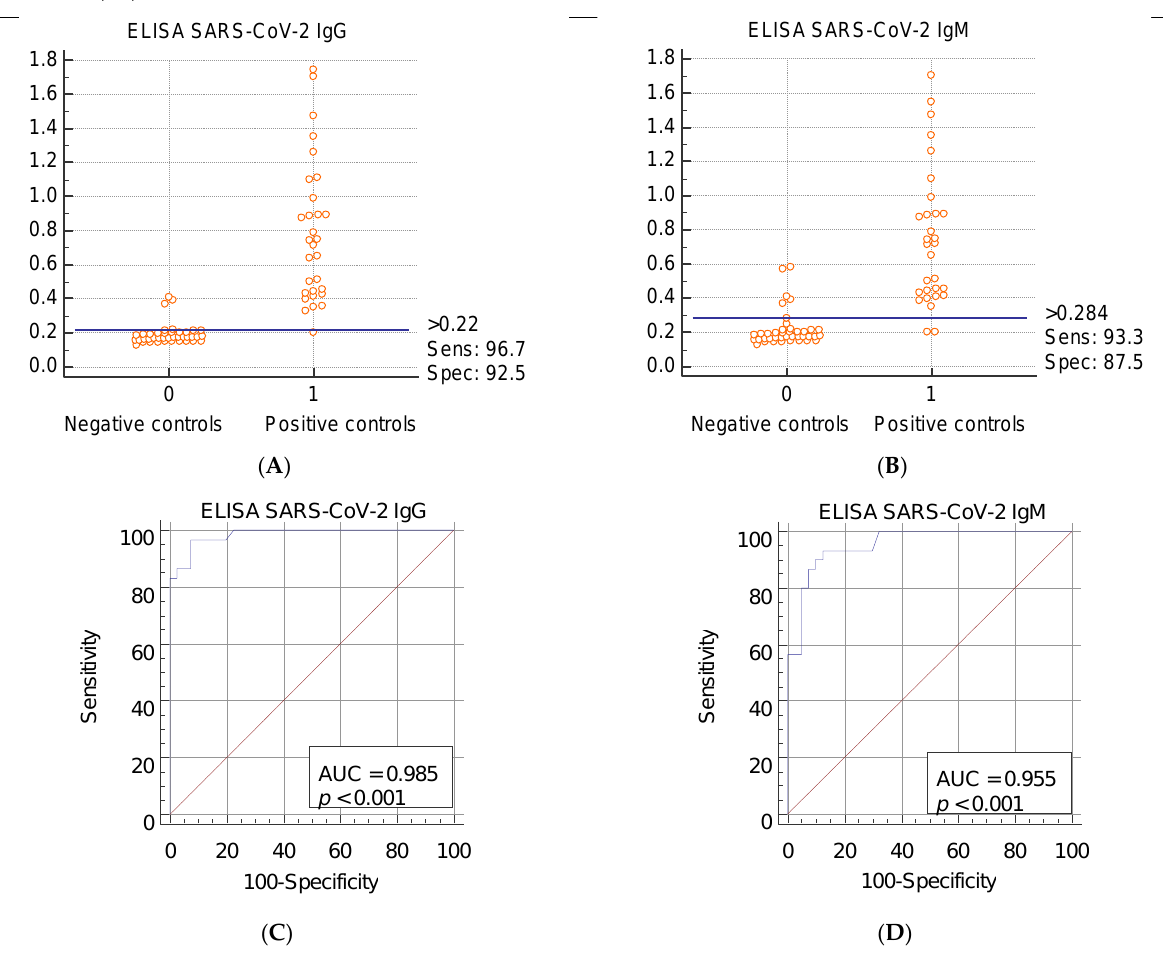
Figure 4. Distribution of the OD values obtained from 40 SARS-CoV-2 negative and 30 SARS-CoV-2 positive human sera samples using recombinant M protein-based SARS-CoV-2 IgG ( A ) and IgM ( B ) indirect ELISA. The ROC curve built for 40 SARS-CoV-2 negative and 30 SARS-CoV-2 positive human sera analyzed by SARS-CoV-2 IgG ( C ) and IgM ( D ) ELISA based on M protein. Table 1. M Protein-Based ELISA IgM and IgG Tests Performance Characteristics.